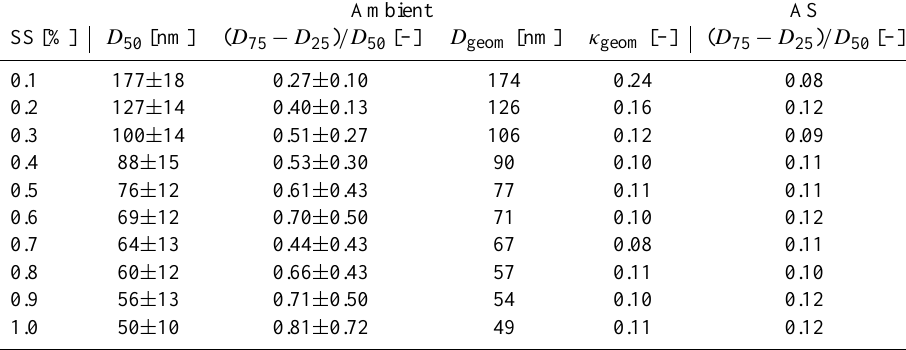
Table 2. Properties of the CCNC-derived hygroscopicity distributions for ambient and ammonium sulphate (AS) aerosols. D 50 (time average ± standard deviation) is the diameter at which 50% of the particles are activated, (D 75 − D 25 ) /D 50 (time average ± standard de- viation) represents the width of the AF distribution, D geom is the geometric mean activation diameter and κ geom is the κ value derived from D geom